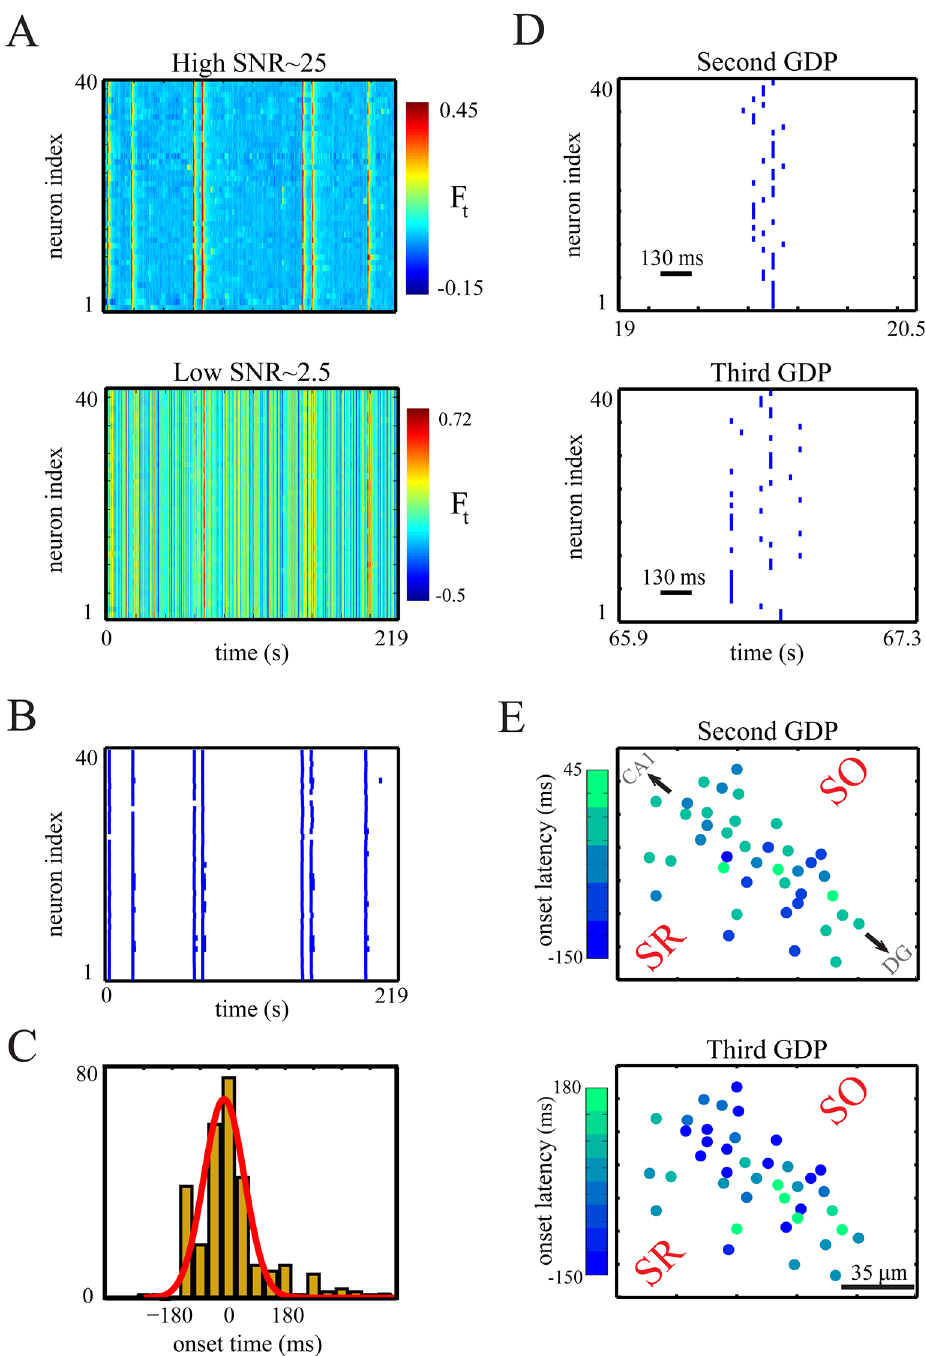
Fig 10. Using the proposed approach for large-scale reconstruction of the cellular activation latencies during GDPs. ( A ) Two raster plots of color-coded in vitro fluorescence traces for 40 CA3 immature neurons. Upper Panel: high SNR condition, Lower panel: low SNR condition. ( B) The reconstructed patterns of onset times of spontaneous activities (both isolated and GDP-mediated events), identified by inverting the QGIF model for low SNR data (lower panel of A ). ( C ) Histogram of cellular activation latency distributions over all reconstructed GDPs and neurons. The red curve shows a Gaussian fit: with mean = -14.5 and std = 90 ms . ( D ) Closer inspection of the reconstructed raster plots in B around the second and third GDPs, unveiling the cellular activation latencies during each GDP. ( E ) The spatiotemporal GDP propagation across neurons can be observed based on color-coded latencies of neurons during the second and third GDPs. SR and SO denote stratum radiatum and stratum oriens of the hippocampal CA3, and DG denotes dentate gyrus.